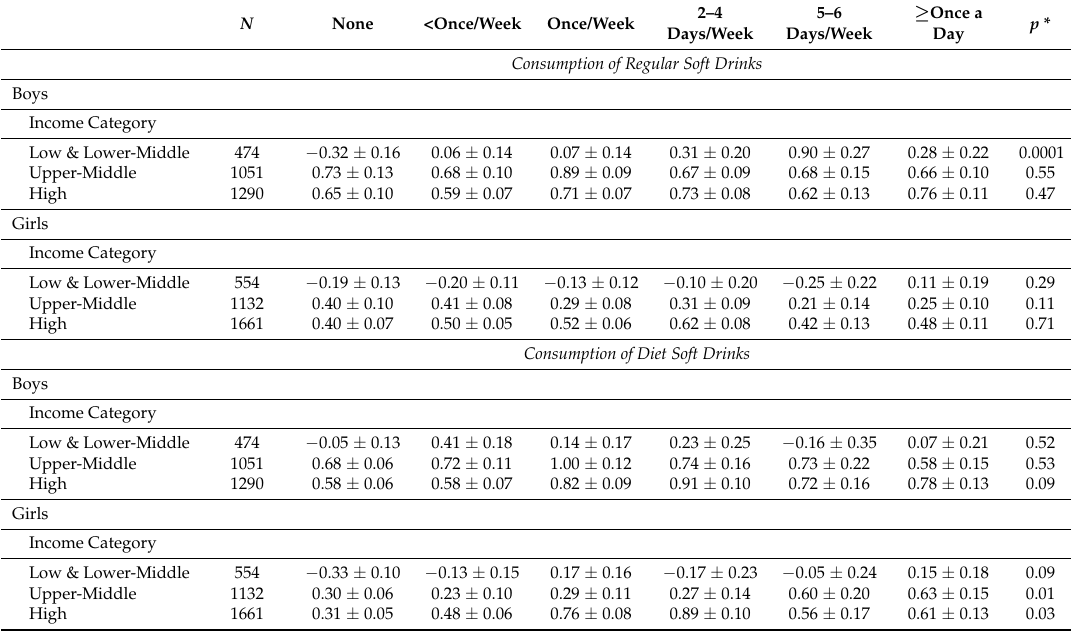
Table 3. Results of multi-level mixed models testing for linear trends in BMI z -scores (mean ± S.E.) across levels of soft drink consumption in boys and girls in the International Study of Childhood Obesity, Lifestyle and the Environment (ISCOLE) stratified by country-level World Bank classification of economic